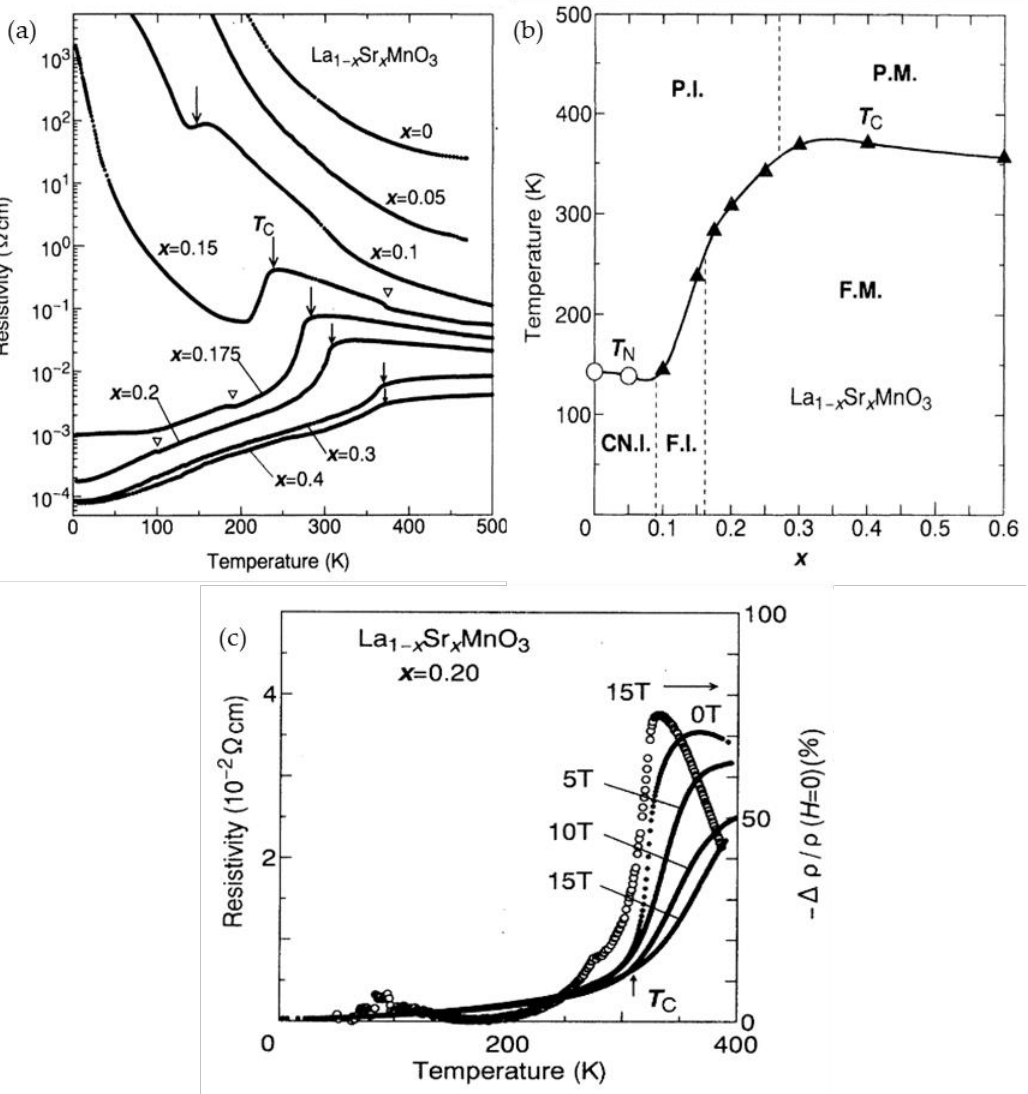
Figure 3. Main characteristics for La 0.8 Sr 0.2 MnO 3 crystals: ( a ) resistivity vs. temperature dependences. Arrows indicate the critical temperature for the paramagnetic-ferromagnetic phase transition. Open triangles indicate structural transition; ( b ) electronic phase diagram. Open circles and filled triangles indicate the Neel ( T N ) and Curie ( T C ) temperatures, respectively. The meaning of abbreviations: paramagnetic insulator (PI), paramagnetic metal (PM), spin-canted insulator (CNI), ferromagnetic insulator (FI), and ferromagnetic metal (FM); and ( c ) resistivity vs. temperature dependence for chemical composition x = 0.20 under various magnetic fields. Reprinted with permission from [41], © 1995 American Physical Society.